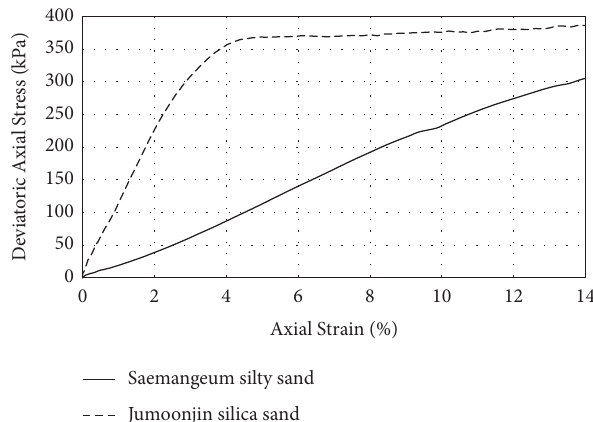
Figure 14: Deviatoric axial stress and axial strain curves of Saemangeum silty sand and Jumunjin silica sand ( D